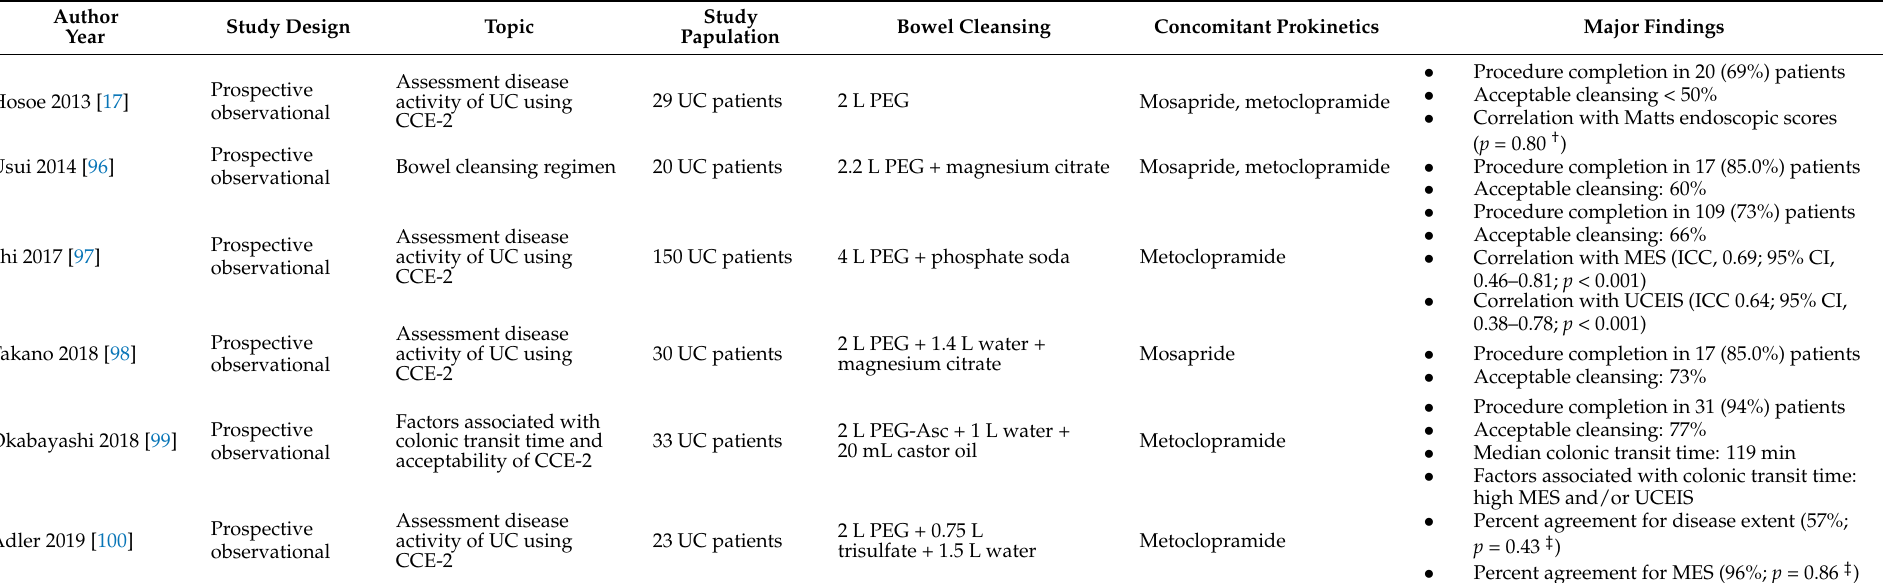
Table 2. Summary of results of studies on the clinical applications of colon capsule endoscopy for ulcerative